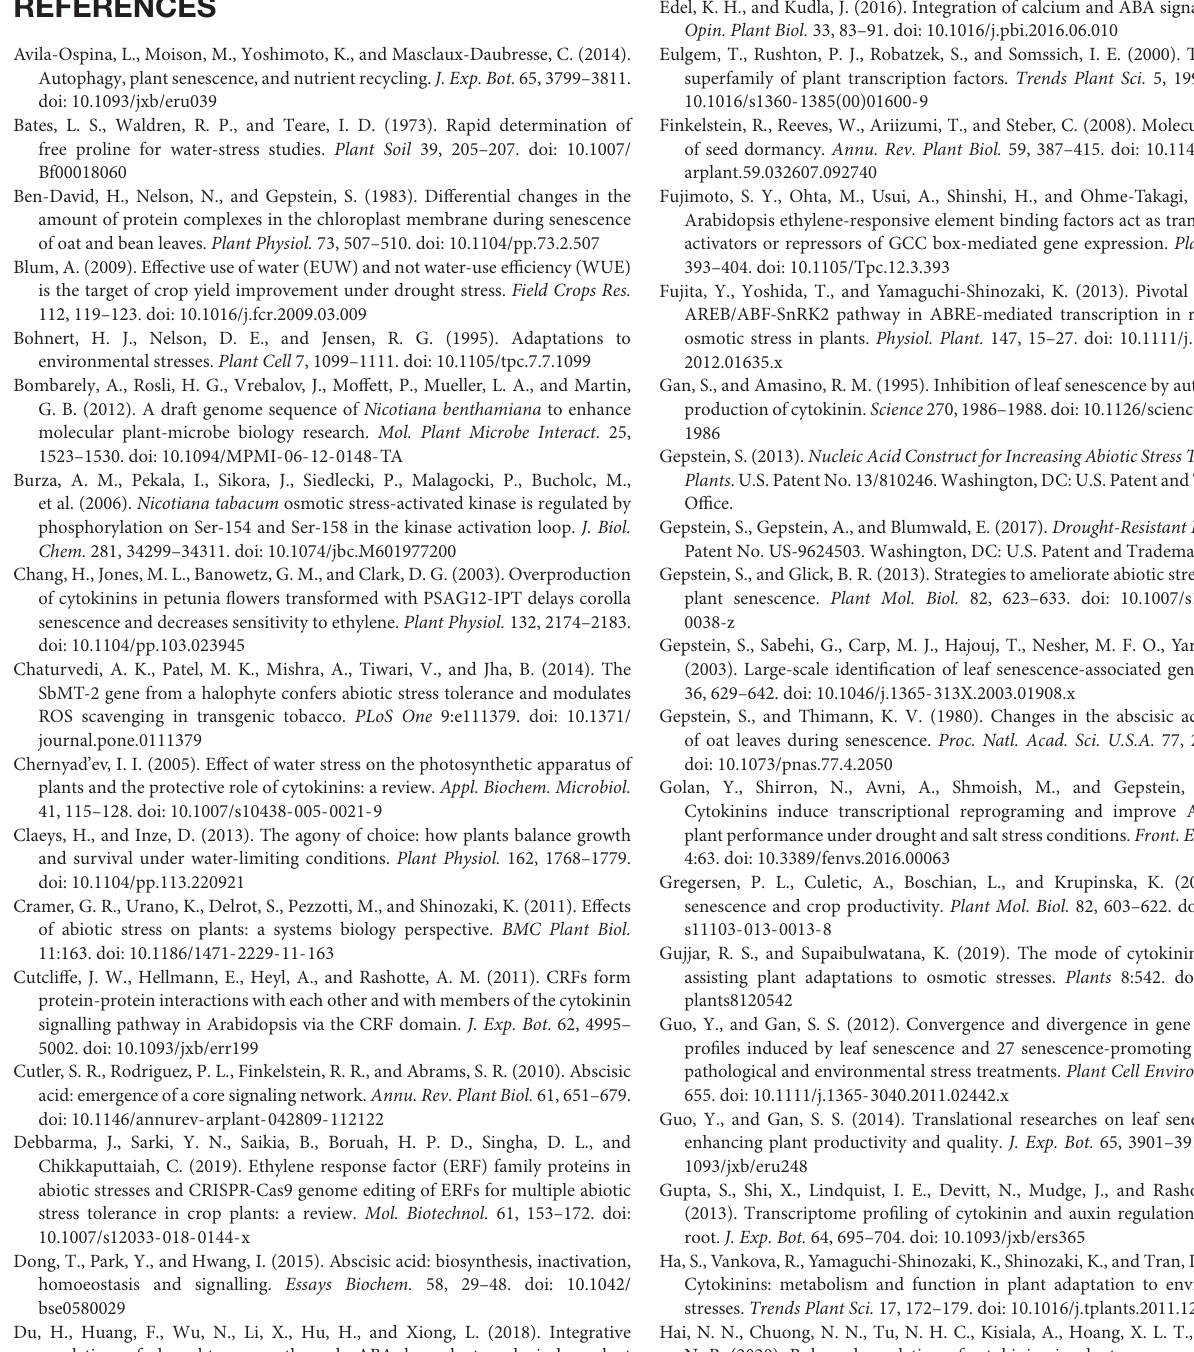
elements (yellow); (3) cupper response elements (double underlined); (4) WRKY elements (blue); (5) ACGT elements (red); (6) GT-1 motifs (grey); (7) MYB recognition sites (violet); and (8) anaerobic condition elements (teal). TABLE S1 | Real-time PCR primers used for quantification of stress related gene